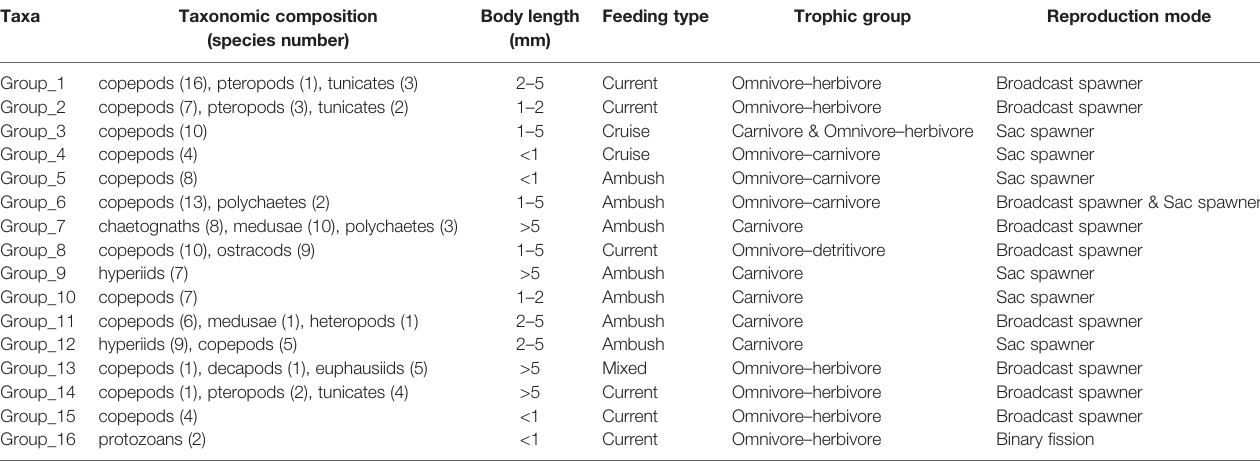
TABLE 1 | Summarized functional traits of the identi fi ed functional groups of